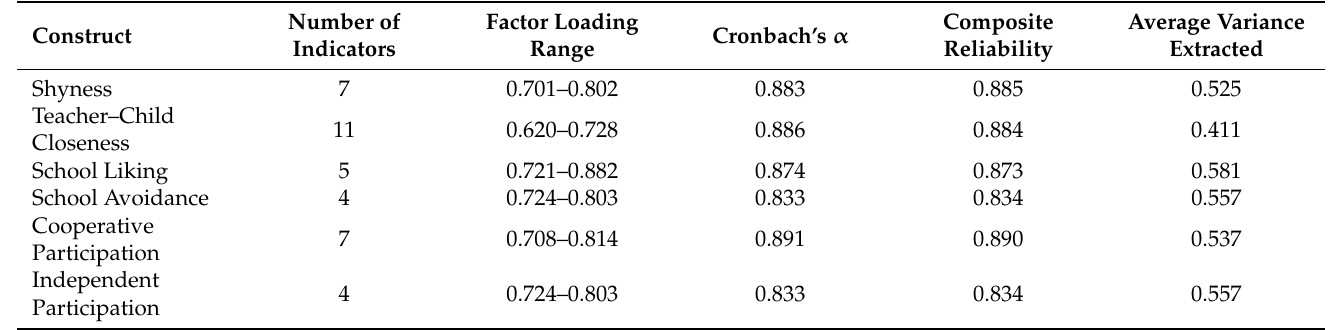
Table 1. The factor loading range, Cronbach’s α , composite reliability, and average variance extracted of